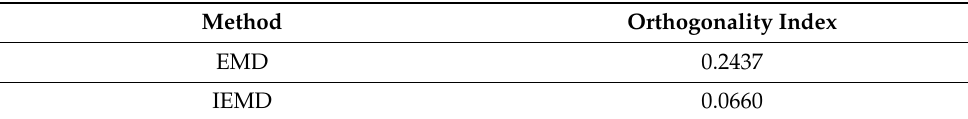
Table 5. Coefficients under different decomposition.